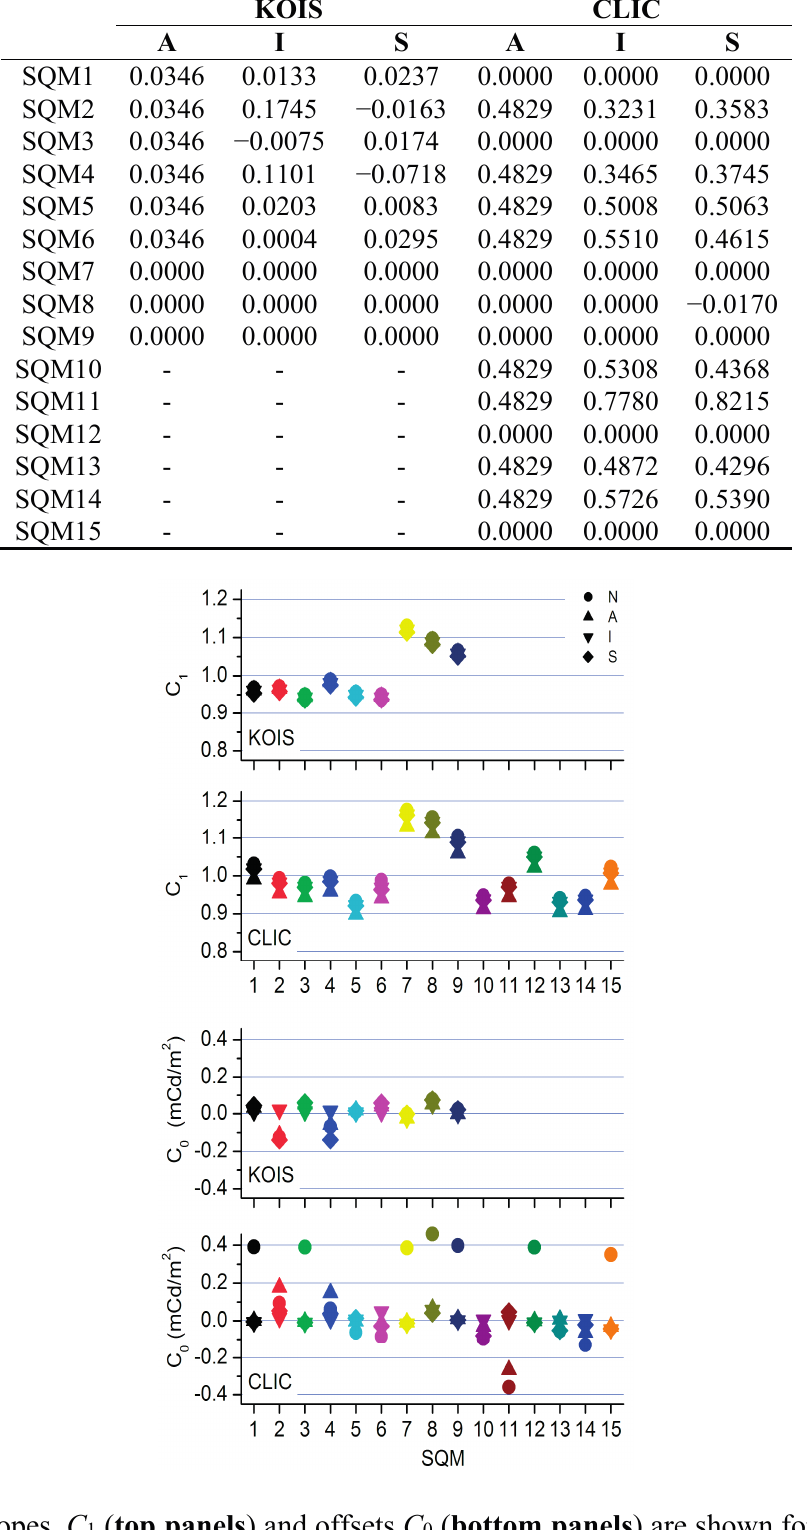
Figure 5. Slopes, C 1 ( top panels ) and offsets C 0 ( bottom panels ) are shown for all SQMs, corrections methods and both campaigns. Different symbols refer to different correction procedures, as indicated by the legend and explained in the text. N : no corrections, A : overall offset correction, I : offsets derived from linear fits, S : offsets yielding a minimum second order